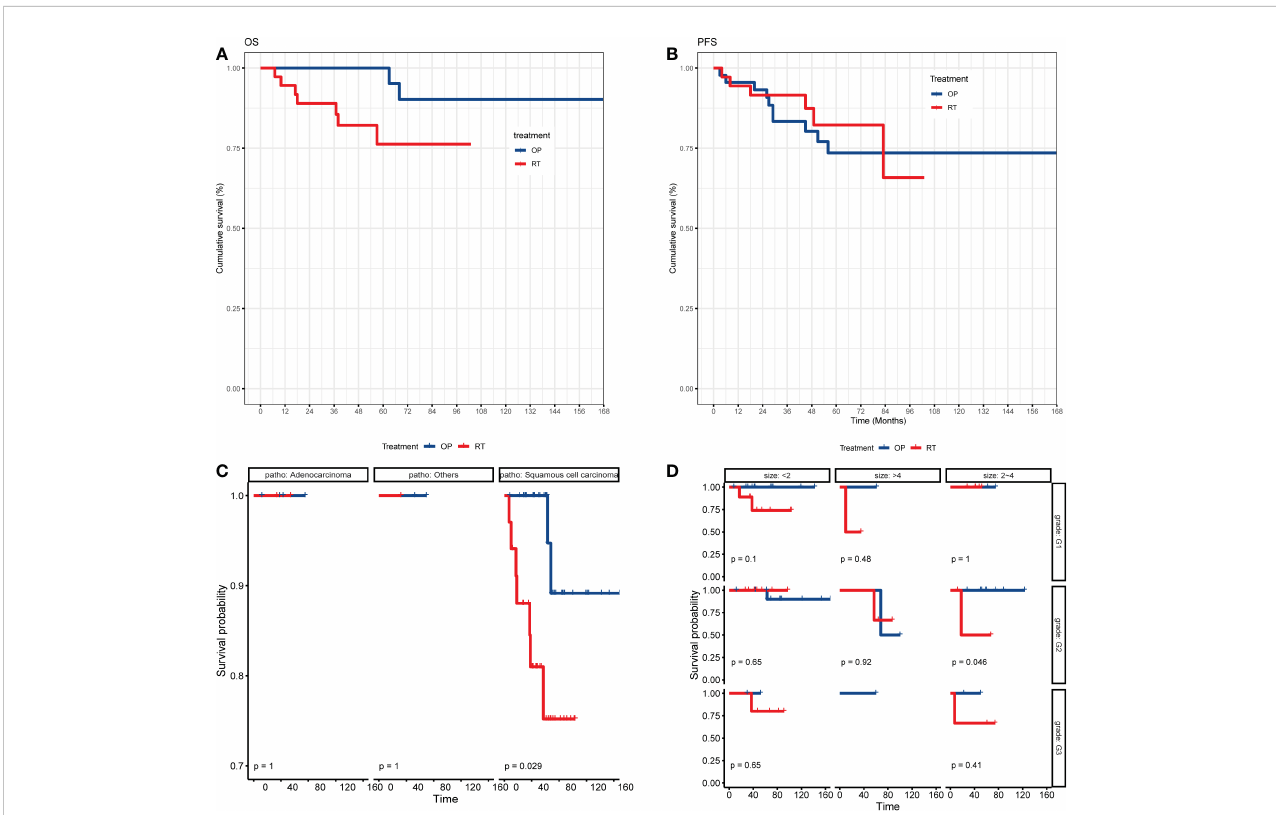
FIGURE 3 The KM analysis of OS and PFS of patients between the OP and RT groups. (A) KM analysis of OS between the OP and RT groups; (B) KM analysis of PFS between the OP and RT groups; (C) subgroup analysis of OS between the OP and RT groups strati fi ed by pathology; (D) subgroup analysis of OS between the OP and RT groups strati fi ed by grade and tumor size. OP, operation group; RT, radiotherapy